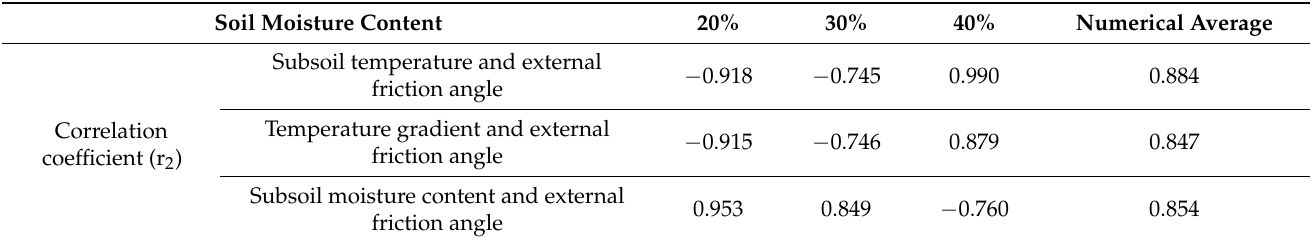
Figure 14. Changes in the surface of the subsoils with moisture contents of 20% and 30% when heated at 100 °C. Table 5. Correlation of external friction with subsoil temperature, subsoil moisture content, and temperature